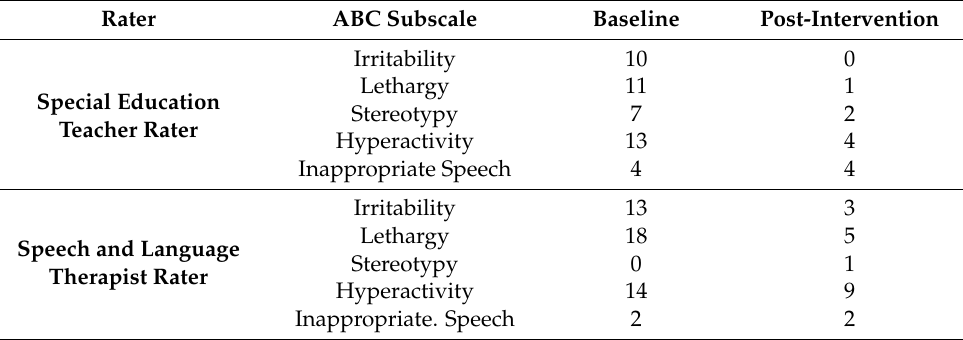
Table 3. Feasibility stage ABC subscale scores for Participant 2.